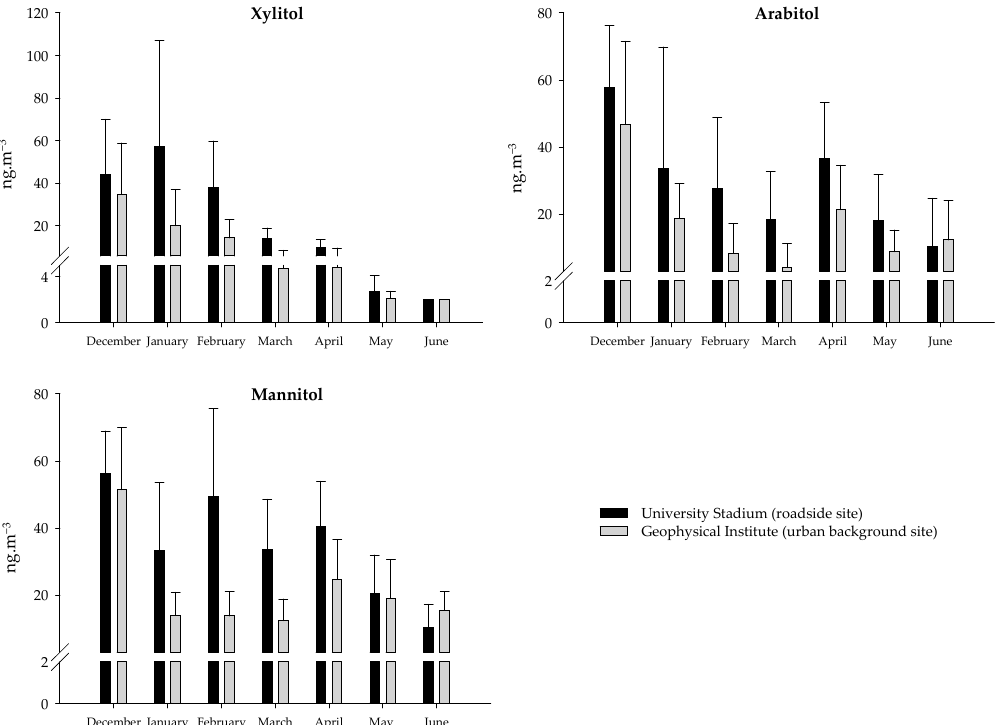
Figure 4. Monthly variation of sugar alcohols during the sampling campaign in Coimbra. Several authors have tried to make quantitative estimates of the contributions of fungal spores to the PM mass and to OC, based on ambient tracer concentrations. One of the possible methods is to use the conversion factors suggested by Bauer et al. [9,54,55]. In the present study, rough quantitative estimates were obtained by using three conversion fac- tors (1) arabitol and mannitol concentration to spore number concentration (1.2 pg arabitol spore − 1 ; 1.7 pg mannitol spore − 1 ); (2) spore number concentration to spore fresh mass con- centration (33 pg fresh mass spore − 1 ) and (3) spore number concentration to organic carbon concentration of spores (13 pg C spore − 1 ). Using the published conversion factor for man- nitol (1.7 pg mannitol spore − 1 ), the average numbers of fungal spores in PM 10 during this study for the roadside site were estimated to be 24,982 spores m − 3 and 15,790 spores m − 3 in the colder and warmer periods, respectively. For the urban background, levels were esti- mated to be 13,344 spores m − 3 and 11,238 spores m − 3 for the same periods. These values are comparable to the fungal spore counts when using the arabitol conversion factor (1.2 pg arabitol spore − 1 ), as can be seen in Table S2 (available on Supplementary Material). For better comparison with results from other studies, the conversion factors (33 pg fresh mass spore − 1 and 13 pg C spore − 1 ) were used to estimate the contribution of fungal spores to ambient PM and OC mass in Coimbra. On average, the relative contributions of fungal spores to the PM 10 mass for the roadside site were 2.7% and 2.8% in the colder and warmer period, respectively. For the urban background site, the average relative contributions were 1.9% and 2.7% for the same periods. The mean relative contributions of fungal spores to OC for the roadside site were estimated to be 6.2% and 8.1% in the colder and warmer period, respectively. The corresponding urban background values were 3.9% and 7.5% for the same periods. These results reveal the importance of the fungal spore contribution to the total aerosol burden in the atmosphere. For the two sites, the fungal spore relative contribution to PM 10 and OC mass was significant and always higher in the warmer pe- riod. These data are comparable with the findings by Bauer et al. [55] (2.3% and 4.3%) and by Emygdio et al. [56] (2% 21and 8%) in other urban areas. In other areas, such as subur- ban sites (4.8% and 10%) [55] and tropical forest (7.9% and 12.1%) [57], the percentages are